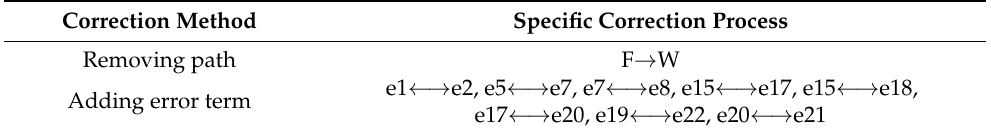
Table 11. Model Correction Process.